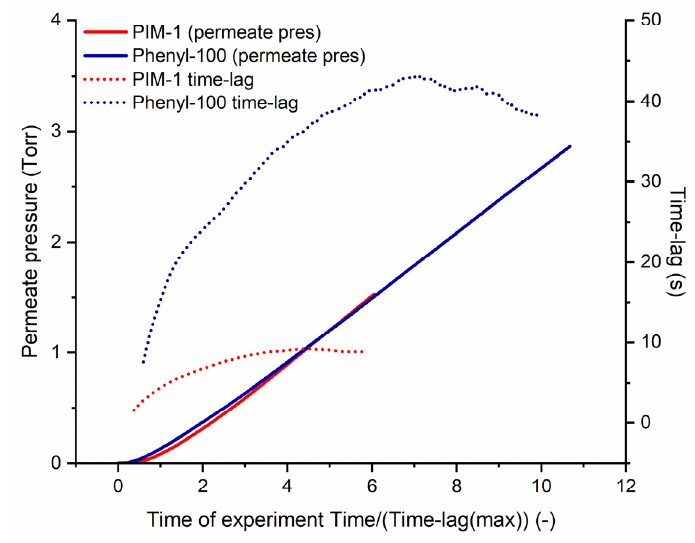
Figure 12. Time-lag curve analysis of PIM-1 and phenyl-100.